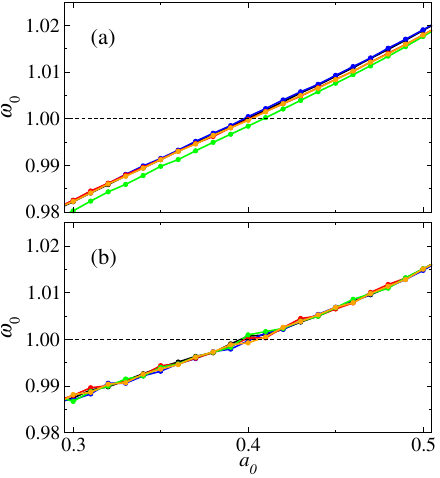
FIG. 3. Mean value of ω 0 in SAC runs with four different noise realizations (shown in different colors) graphed vs the amplitude parameter a 0 . The noise levels are 10 − 5 and 10 − 6 in panels (a) and (b), respectively, and the number of δ functions was N ω ¼ 1000 and N ω ¼ 2000 . In both cases, G ð τ Þ values were generated on a uniform grid with Δ τ ¼ 0 . 1 for τ up to the point where the relative error exceeds 10%.